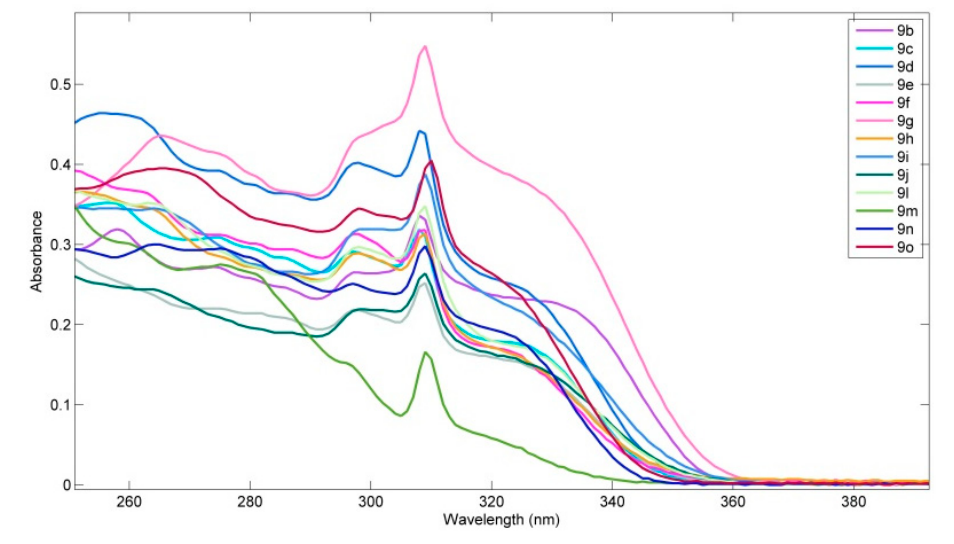
Figure 3. Absorption spectra of 9 (10 − 5 M) in